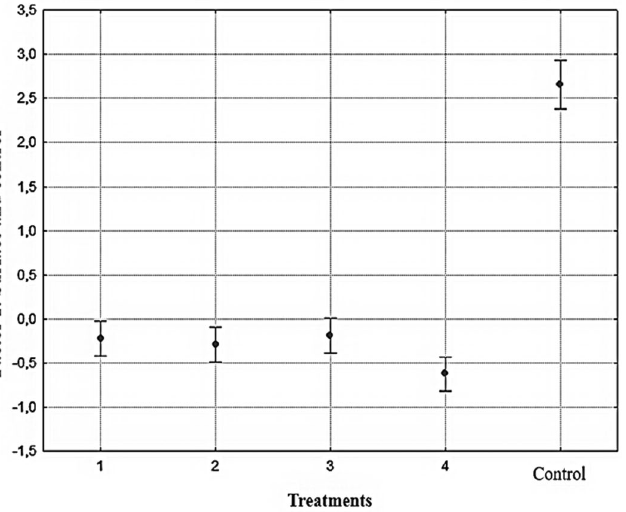
Figure 1. Graphical representation with the scores of Factor 1 (surface and control) as a function of the evaluated samples. Vertical bars represent confidence intervals of 0.95 (F = 109.58; p = 0.0001). Spray solution: 1-No adjuvant; 2-herbicide associated with vegetable oil; 3- herbicide associated with mineral oil; 4-herbicide associated with lecithin, and Control.